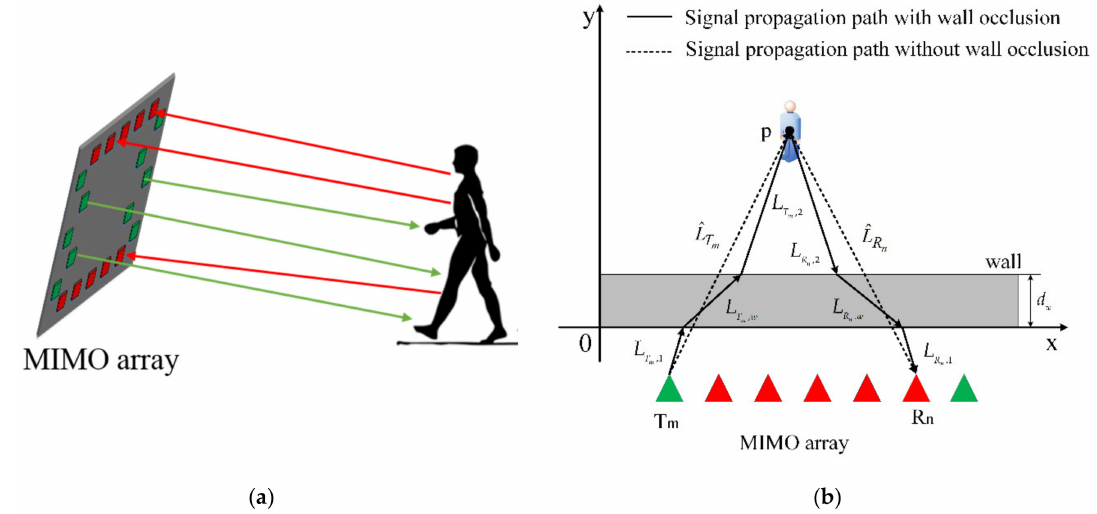
Figure 1. ( a ) Sketch map of multiple-input multiple-output (MIMO) radar human detection; ( b ) Geometric schematic diagram of MIMO radar through-wall